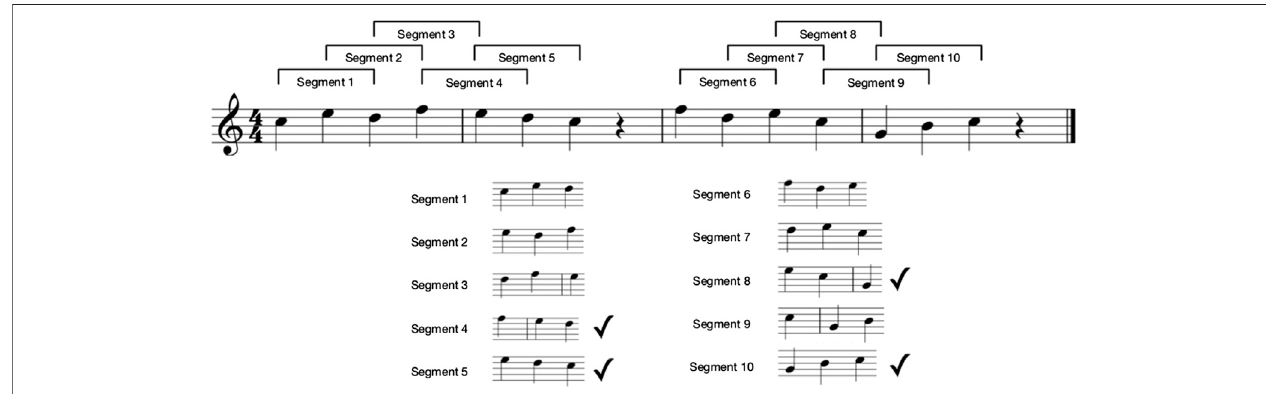
FIGURE 4 | Calculating the shape of a melody. Tick marks indicate the segments which are counted as having shape , as the pitches within the segment move consistently up or down.